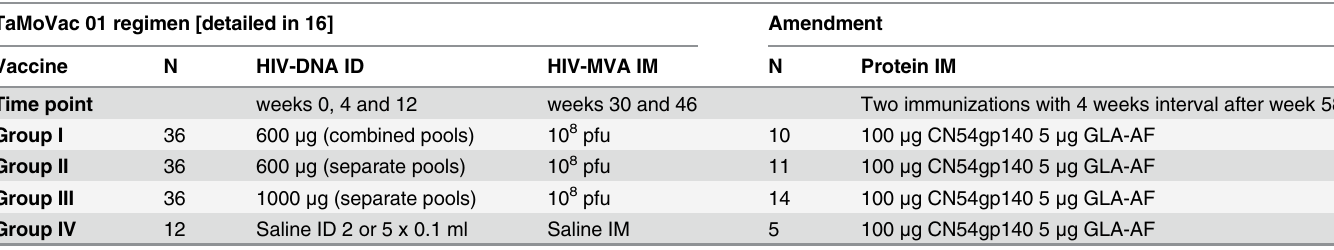
N: number of participants. Combined pools refer to a combination of pool 1 (EnvABC/RevB) and pool 2 (GagAB/RTmutB) and separated pools refer to separate administration of pool 1 and 2 into the left and right arm, respectively.